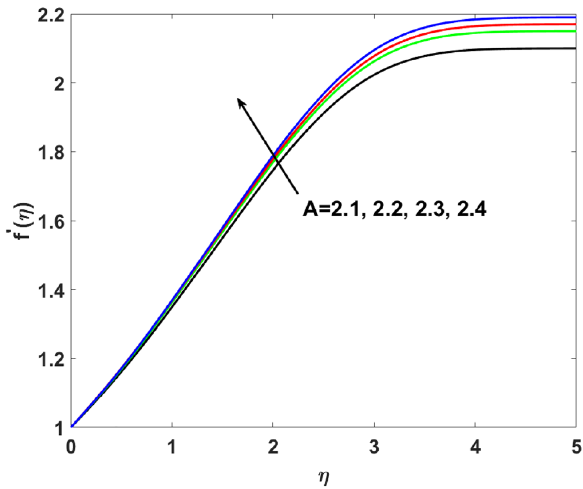
Figure 2. f ′ (η) versus A .